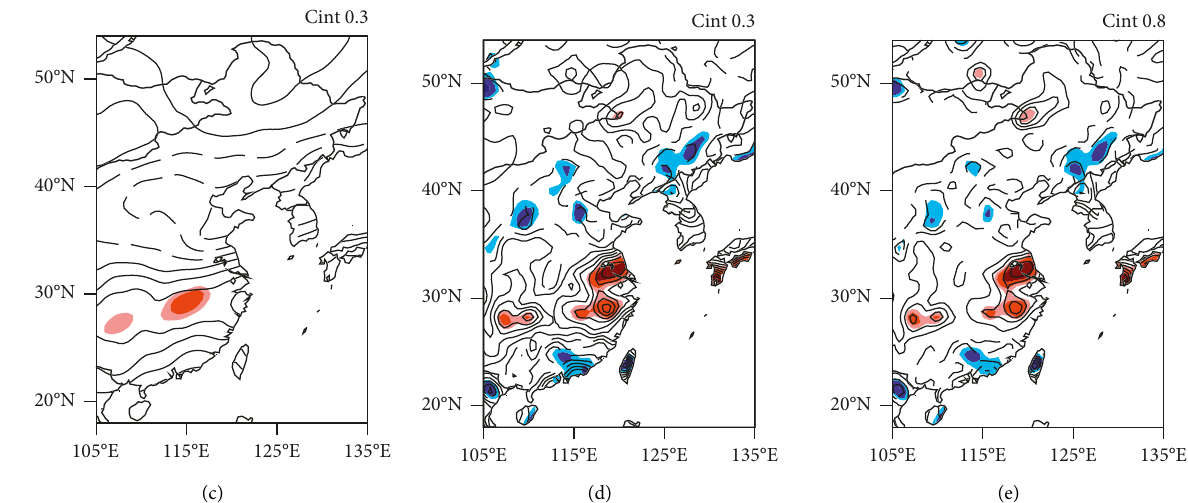
Figure 9: PC2-regressed column-integrated water vapor flux (a) and its divergence (b), total precipitable water (c), precipitation (d), and precipitation efficiency (e) in boreal summer during 2000–2016. Thick vectors in (a) denote the significant areas at the 95% level. Solid (dashed) contours denote positive (negative) anomalies, and red (blue) color shadings from light to dark for significant areas at 90%, 95%, and 99% levels.